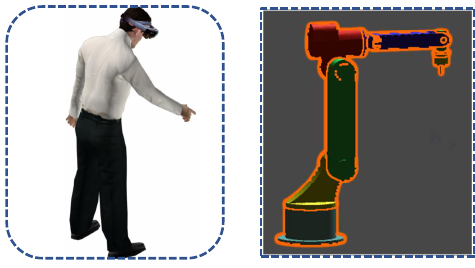
Figure 2. 3D reconstruction for training a cooperative robot, which provides training samples and allows the robot to learn to avoid obstacles in a virtual